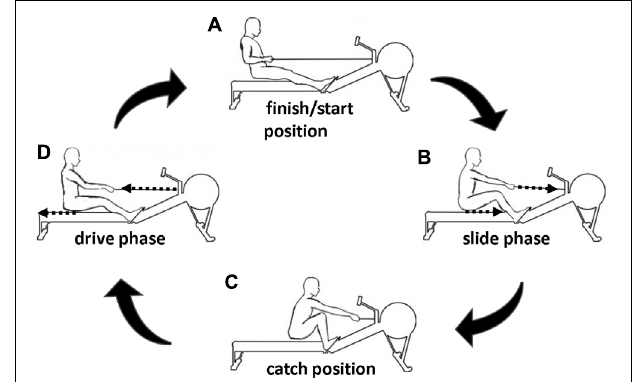
FIGURE 1 | Exemplary representation of a rowing cycle separated into different phases: slide (B) and drive (D) phase. The finish/start (A) and catch (C) position are the turning points of the extension and flexion phase, respectively.